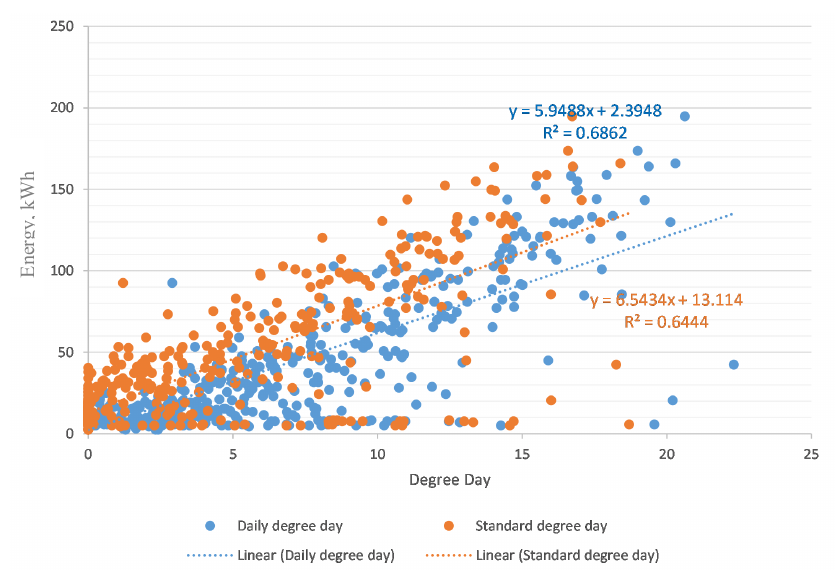
Fig. 2. Energy consumption versus degree-days for house 1 with daily approach.